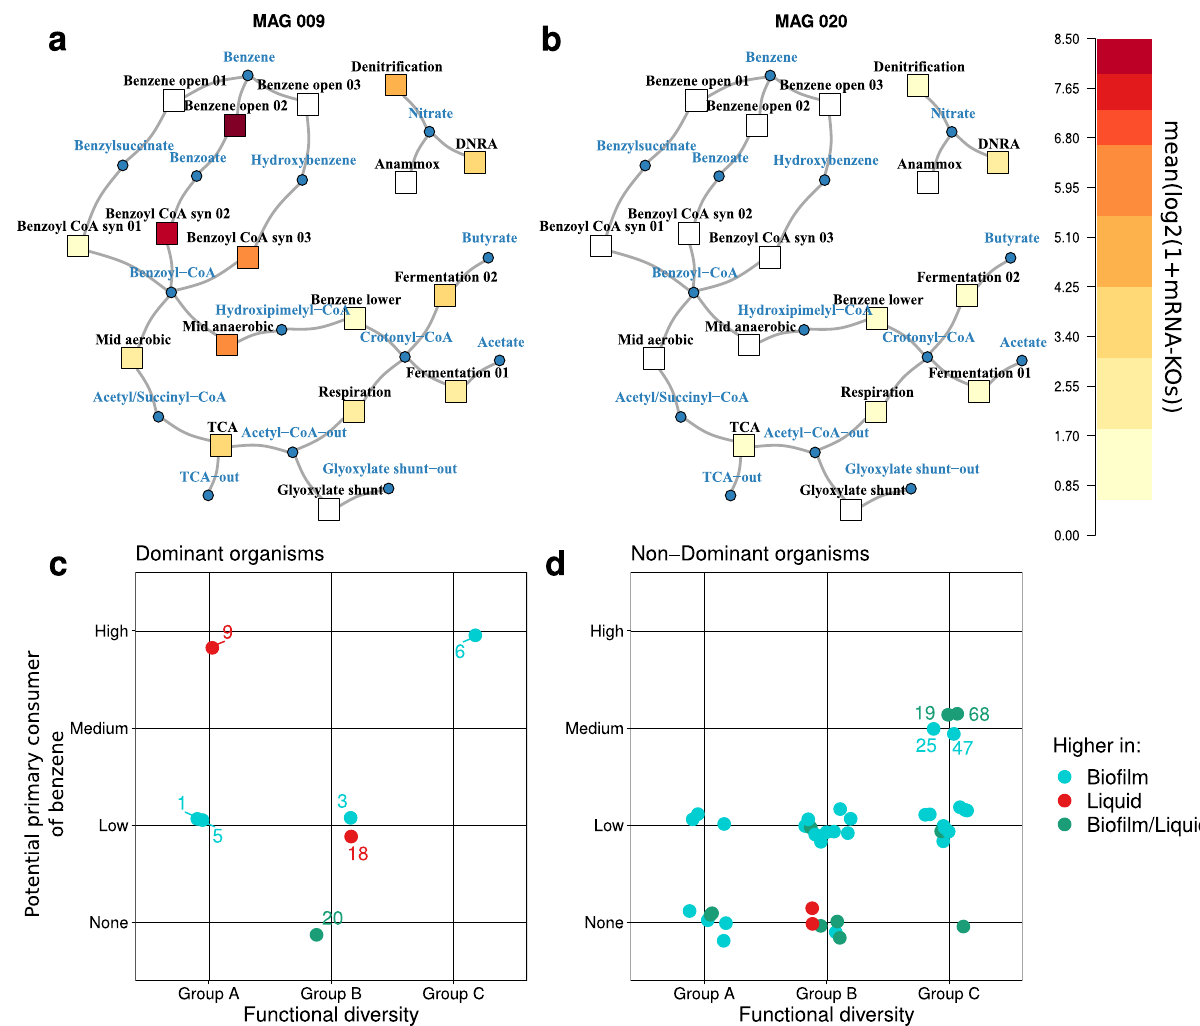
Fig. 2 Metabolic heatmaps of anaerobic benzene degradation in MAGs 9 ( Peptococcaceae ), and 20 ( Ignavibacteriaceae ) and relationship between functional diversity and potential to degrade benzene. a Heatmaps of MAGs 9 and b 20, which are dominant members of the community with the highest and lowest potential for benzene metabolism, respectively. The square nodes represent the average transcription of a lumped group of genes that encode enzymes of each branch, and the circular nodes correspond to intermediate compounds. The two lower fi gures are overviews illustrating the potential of MAGs to be a primary consumer of benzene (the ability to activate and further degrade benzene) based on a custom classi fi cation for c dominant and d non-dominant MAGs. The colours indicate the culture phase in which MAGs show signi fi cantly higher speci fi c RNA abundance. The functional diversity is derived from the three groups of Fig. 1. Note that only a few MAGs are assigned as potential primary consumers of benzene, while the majority of the MAGs are not, including dominant MAGs such as 1, 3, 5, 18 and 20. Data are shown jittered for both